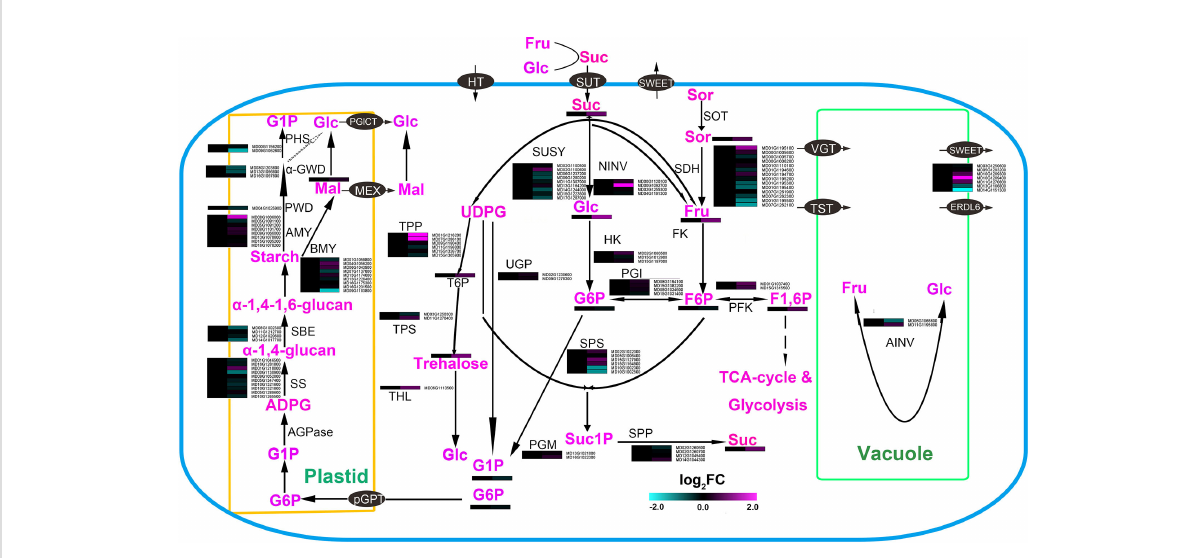
FIGURE 4 Main carbohydrate metabolism and sugar accumulation pathways in roots of apple plants inoculated with R . irregularis for 60 days. CWINV, cell wall invertase; FK, fructokinase; F6P, fructose-6-phosphate; Fru, D-fructose; Glc, D-glucose; G6P, glucose-6-phosphate; Tre, trehalose; Gal, galactose; GPT, glucose-6-phosphatetransporter; SDH, sorbitol dehydrogenese; HK, hexokinase; NINV, neutral invertase; PFK, phosphofructokinase; PGI, phosphoglucoisomerase; pGLCT, plastidic Glc transporter;PGM, phosphoglucomutase; SPP, sucrose-phosphate phosphatase; SPS, sucrose-phosphate synthase; SUSY, sucrose synthase; vAINV, vacuolar acidinvertase; vGT, vacuole glucose transporter; UGP, UDPG-pyrophosphorylase; BMY, beta amylase; HGL, heteroglycan glucosidase; PHS, a -glucanphosphorylase; AMY, a - amylase; a -GWD, a - glucan water dikinase; PWD, phosphoglucan waterdikinase; SBE, starch branching enzyme; SS, starchsynthase; TST, tonoplast sugar transporter; TPS, trehalose-phosphate synthase; a -gal, a -galactosidase; GALK, galactokinase; THL, trehalase; T6P,